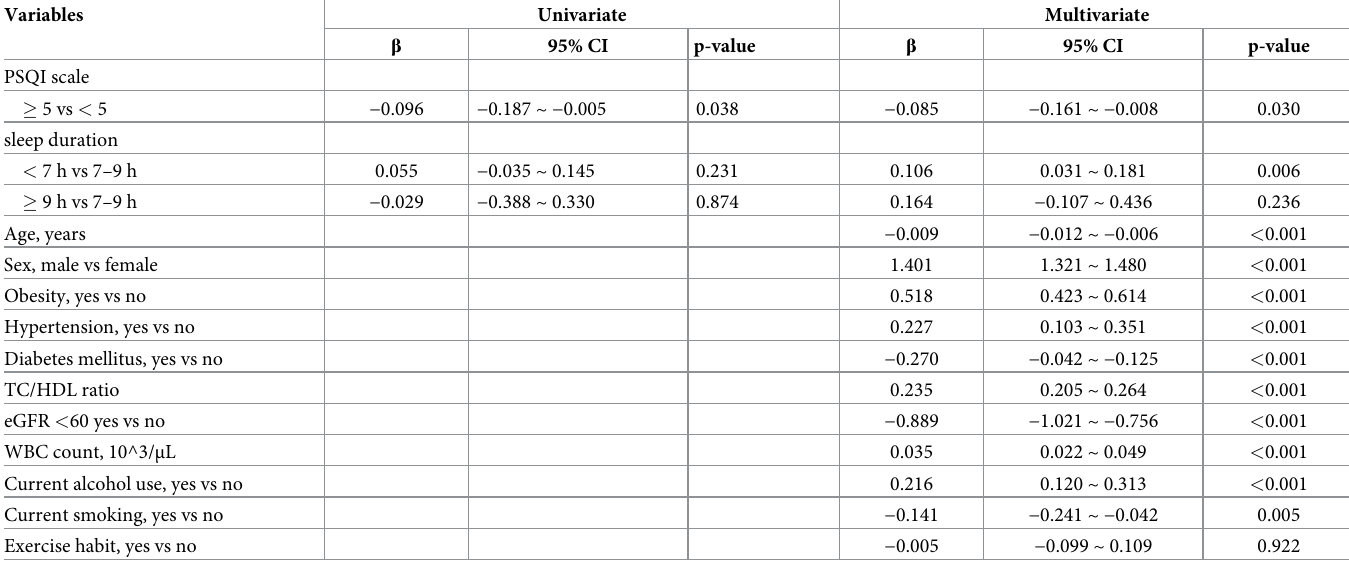
Table 3. Associations between sleep quality, sleep duration, and uric acid levels based on the linear regression